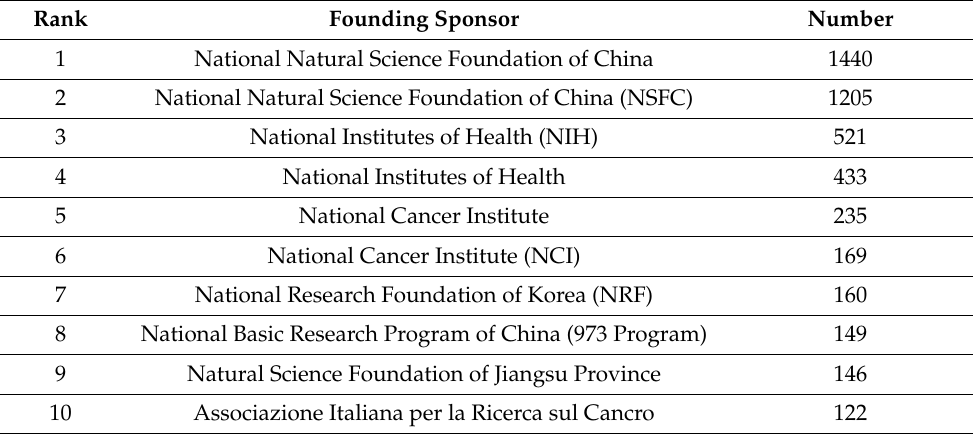
Table 8. Top 10 funding sponsors for articles on miRNA in cancer